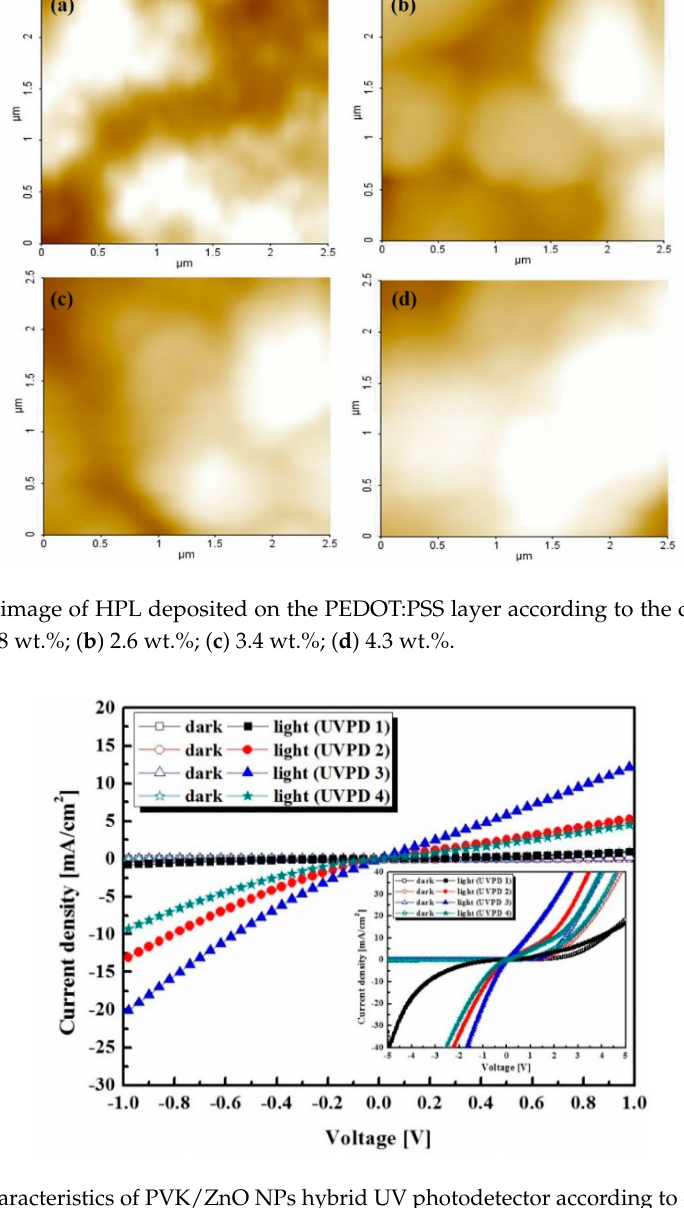
Figure 7. J-V characteristics of PVK/ZnO NPs hybrid UV photodetector according to concentration of ZnO NPs under UV illumination of 1 mW/cm 2 and inset image shows J-V curve of pn-junctions in the UV photodetector. Table 1. Dark and photocurrent density of devices according to concentration of ZnO